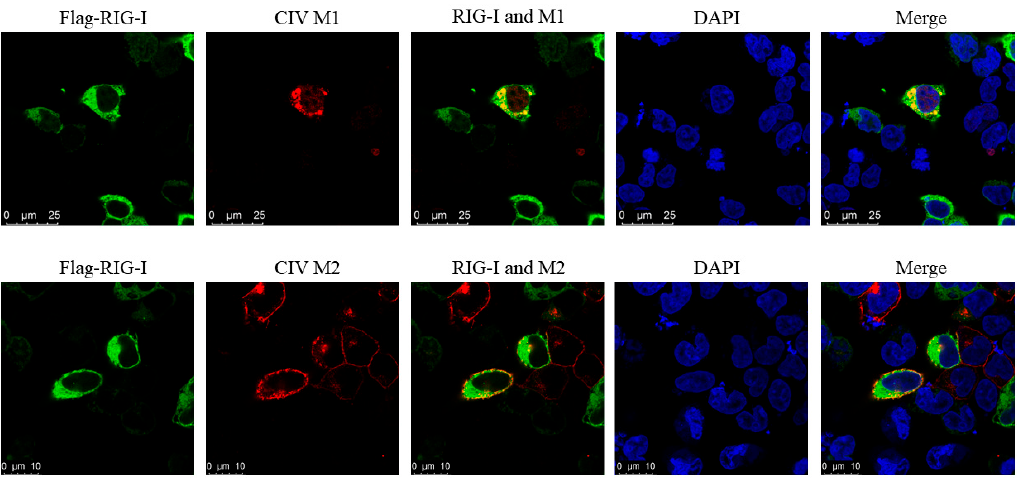
Figure 9. Interactions between CIV M1/M2 and canine RIG-I detected by IFA assay in CIV infection. HEK 293T cells was first transfected with Flag-RIG-I for 24 h, and they were secondarily infected with CIV for 24 h.